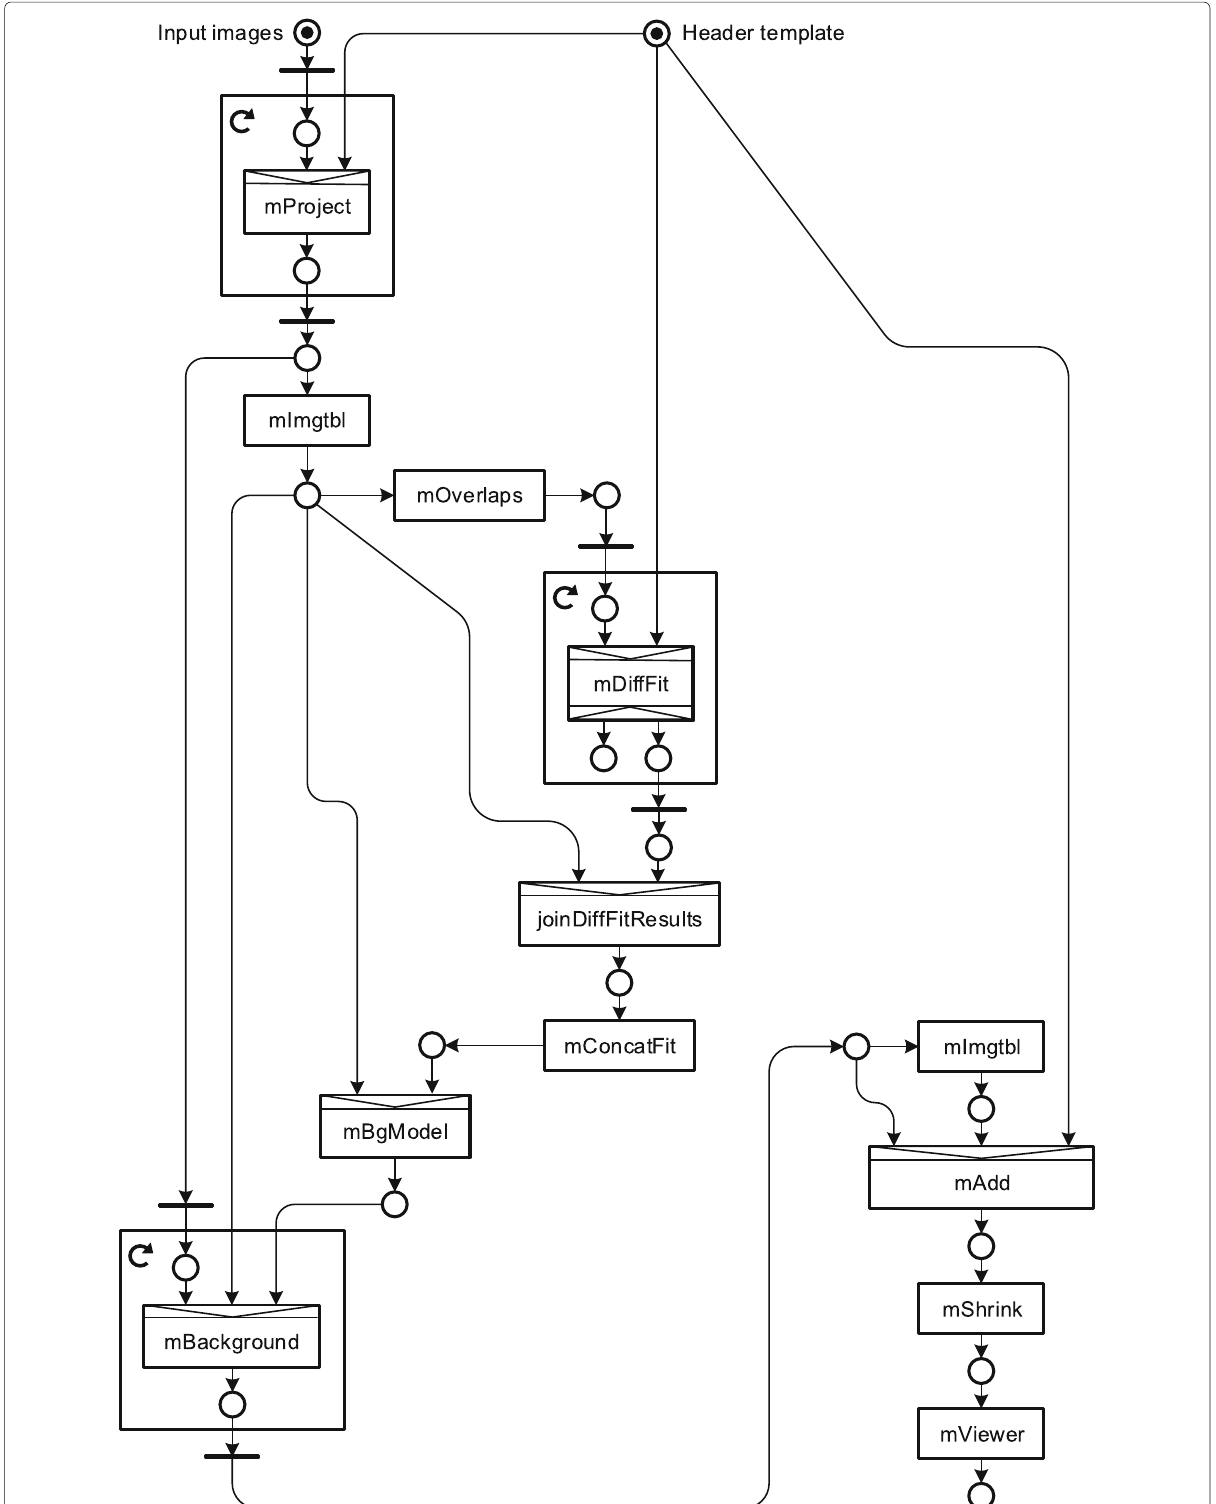
Fig. 15 The Montage workflow for one frequency